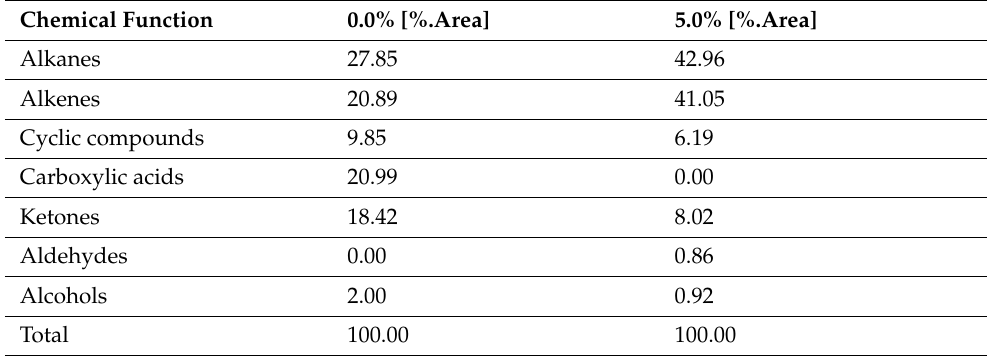
Table 11. Chemical functions present in liquid bio-oil obtained through thermal cracking and catalytic upgrading with 5.0% red mud pellets fixed bed, reaction time of 20 min.